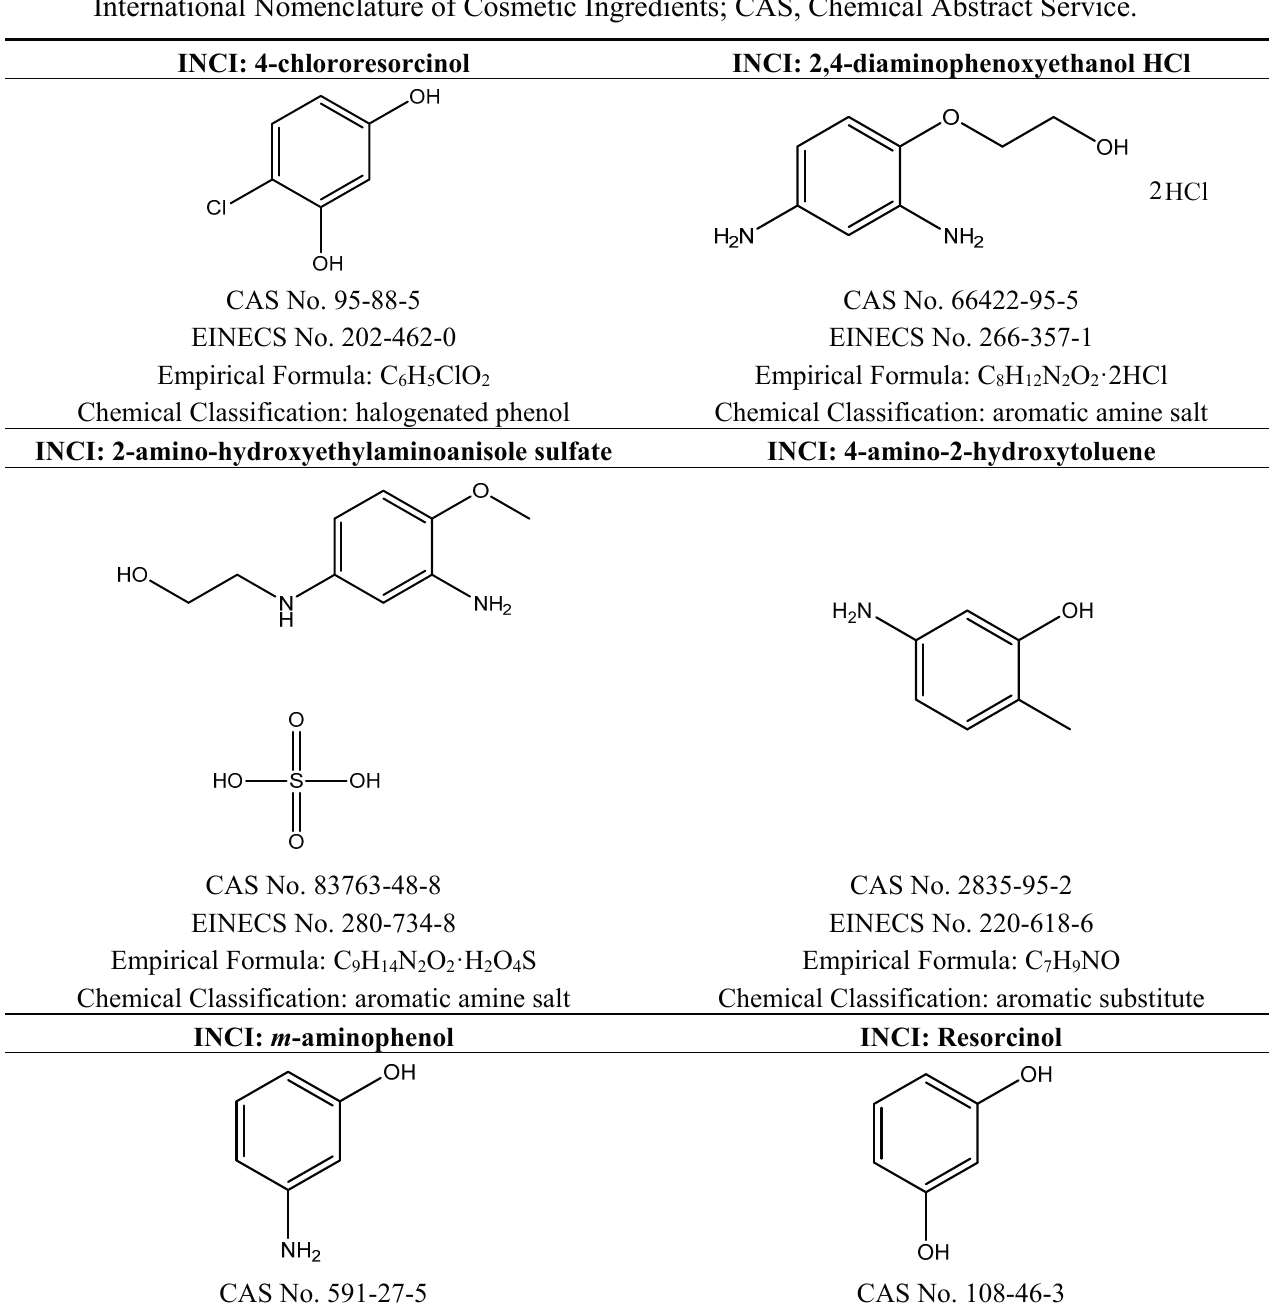
Table 4. Molecular and structural formulas of reaction modifiers [23]. Legend: INCI, International Nomenclature of Cosmetic Ingredients; CAS, Chemical Abstract